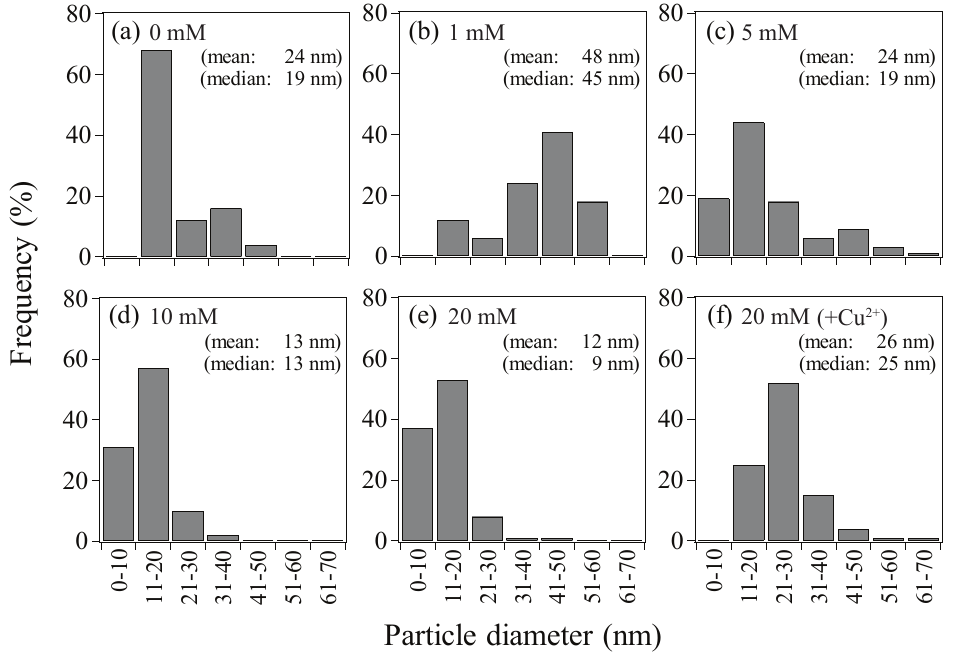
Figure 6. Particle size distribution of Au(0) bionanoparticles produced by Ac. aromatica at initial formate concentrations of; ( a ) 0 mM (cf., Figure 5a, n = 25), ( b ) 1 mM (cf., Figure 5b, n = 18), ( c ) 5 mM (cf., Figure 5c, n = 119), ( d ) 10 mM (cf., Figure 5d, n = 493), ( e ) 20 mM (cf., Figure 5e, n = 681) or ( f ) 20 mM + Cu 2 + (cf., Figure 5f, n =